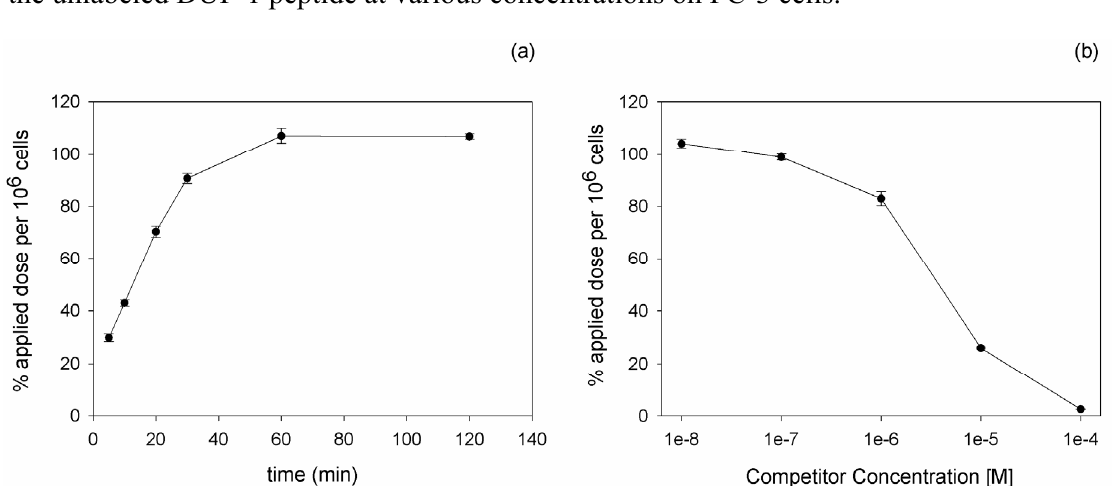
Figure 1. (a) In vitro cell accumulation of 111 In-DOTA-Lys-DUP-1 on prostate carcinoma PC-3 cells as a function of time. (b) Displacement of bound 111 In-DOTA-Lys-DUP-1 by the unlabeled DUP-1 peptide at various concentrations on PC-3 cells.